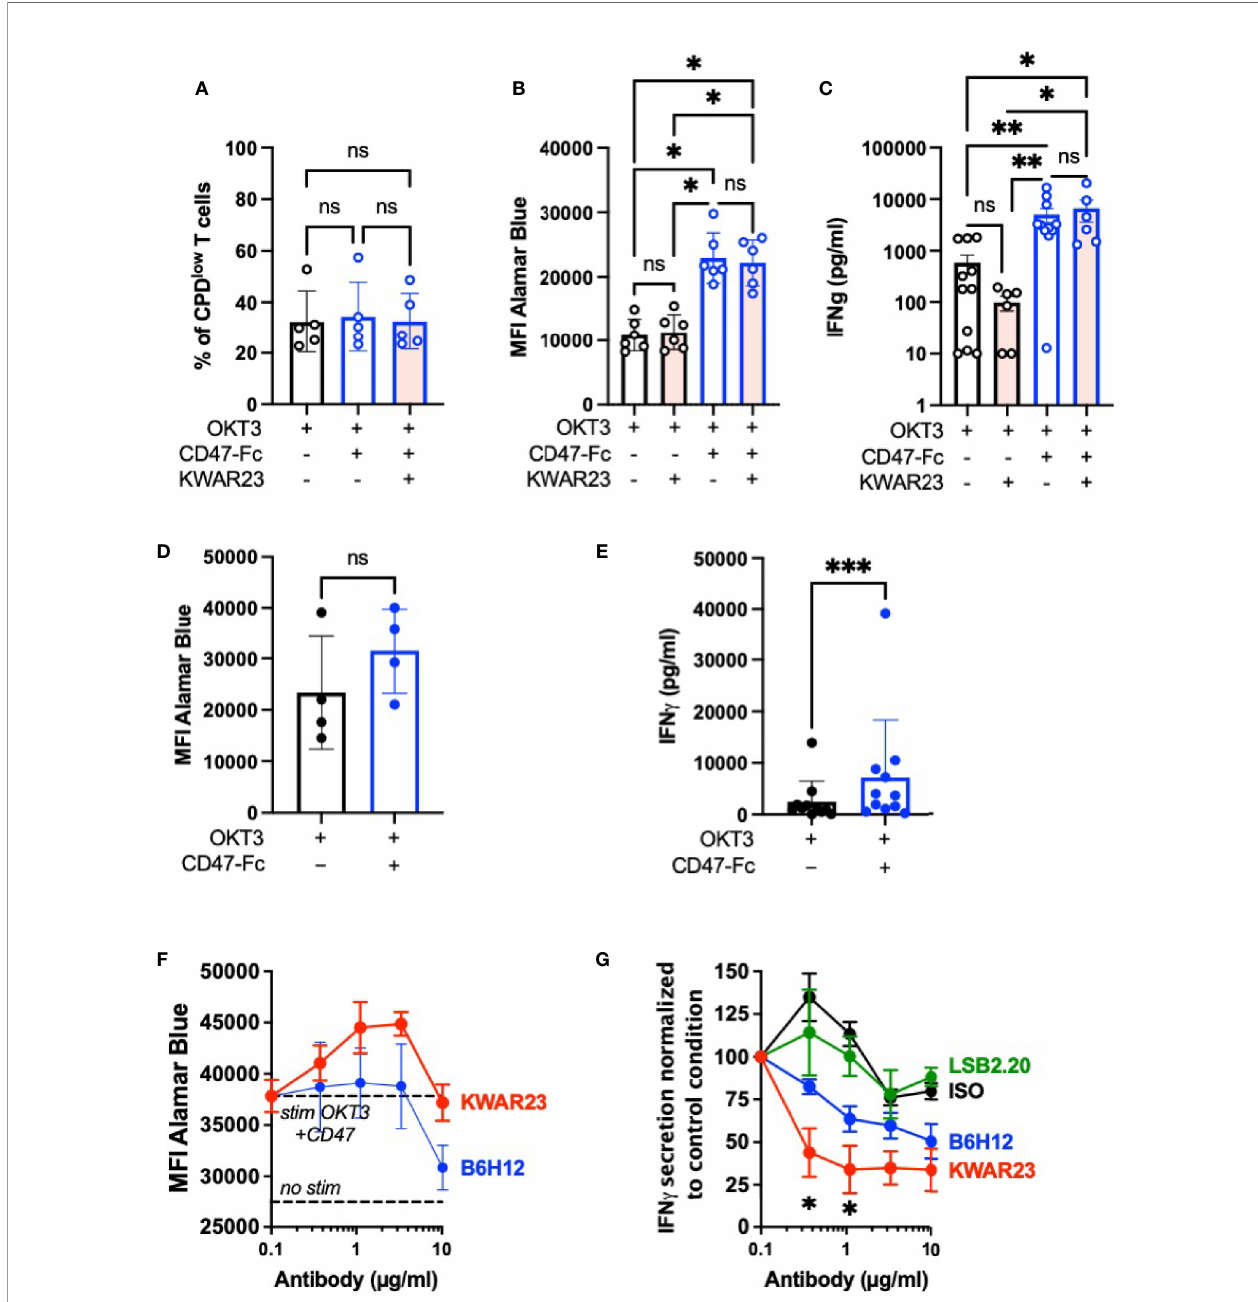
FIGURE 5 | Inhibition of SIRP g /CD47 interaction reduces IFN- g secretion by chronically activated T cells. (A – C) T cells were stimulated once with coated OKT3 (0.5 – 1 µg/ml) with or without coated CD47-Fc (10 µg/ml) in the presence or not of KWAR23. (A) T-cell proliferation after 5 days of stimulation was analyzed by CPD dilution assay ( n = 3 independent experiments with a total of four different HV). (B) T-cell fi tness was evaluated with Alamar Blue at Day 5; n = 4. (C) IFN- g dosage in the supernatant of T cells after 2 days of stimulation in depicted stimulation conditions ( n = 12 within seven independent experiments). (A – C) Statistical analyses were performed with a one-way ANOVA test followed by Kruskal-Wallis; * p ≤ 0.05; ** p ≤ 0.01; *** p ≤ 0.001, ns, not signi fi cant. (D, E) T cell subjected to three rounds of stimulation with coated OKT3 and anti-CD28 were further stimulated by a coated OKT3 stimulation with or without coated CD47-Fc (10 µg/ml). (D) T-cell fi tness was evaluated with Alamar Blue at Day 5. (E) Supernatant were collected 48 h after the last stimulation and IFN- g secretion was evaluated by ELISA. (D, E) Statistical analyses were performed by a Wilcoxon test. ns, not signi fi cant. (F, G) T cells subjected to three rounds of stimulation as previously mentioned were further stimulated during 48 h by a coated OKT3 stimulation with or without coated CD47-Fc (10 µg/ml) with various concentrations of KWAR23, B6H12, or LSB2.2O. T-cell fi tness was evaluated with Alamar Blue, n = 2 (mean ± SEM). (G) Supernatants collected at 48 h were analyzed by ELISA. Statistical analyses were performed by a Kruskal-Wallis test. * p ≤ 0.05 between KWAR23 and ISO and KWAR23 and LSB2.20 when Ab were used at 1.1 µg/ml; * p ≤ 0.05 between KWAR23 and ISO when Ab were used at 0.37 µg/ml. n = 3 – 5 (mean ±